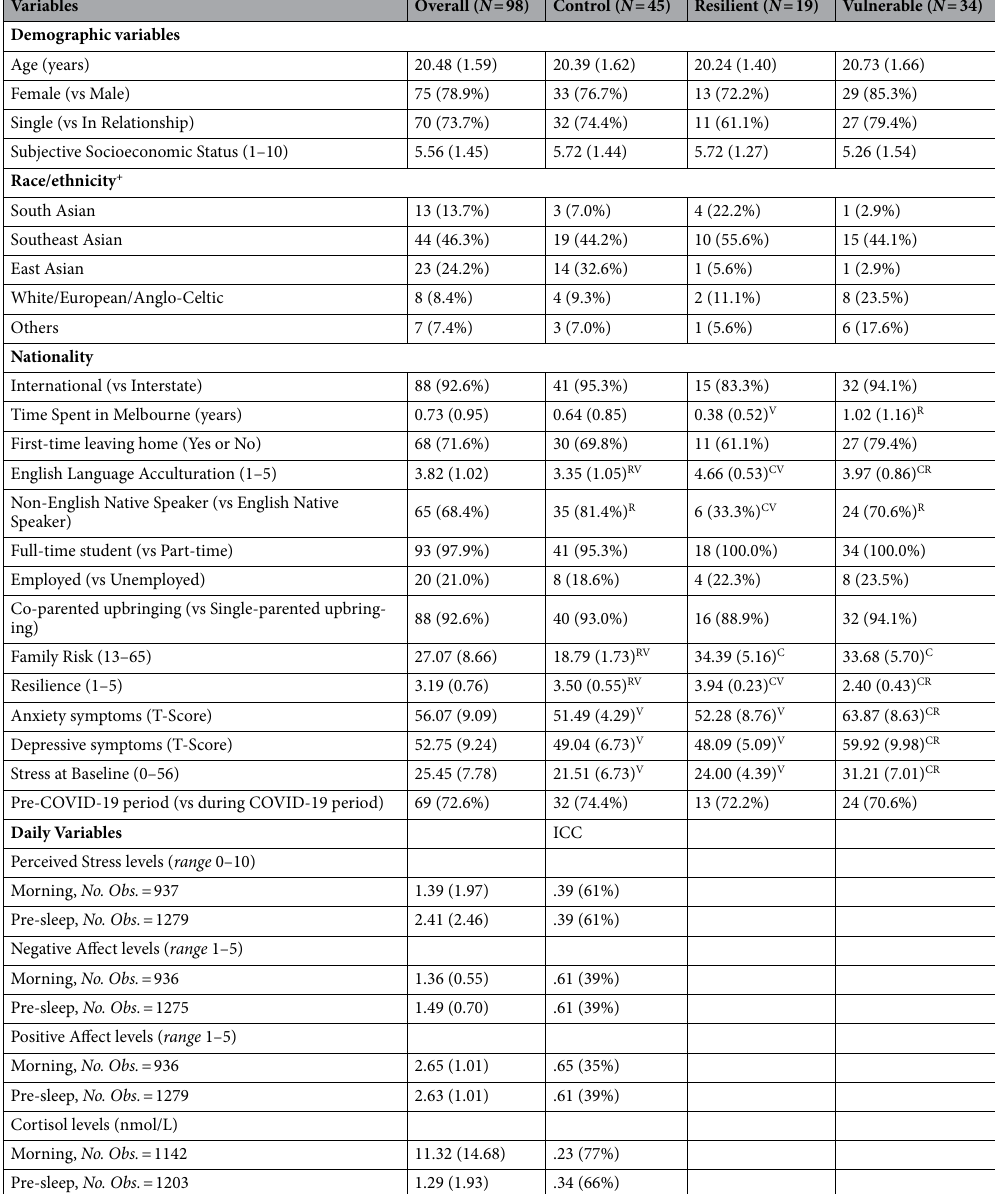
Table 1. Descriptive statistics for demographic and daily variables (N = 95) by groups. ICC Intraclass Correlations, No. of Obs Number of observations. Results are M (SD) for continuous variables and N (%) for categorical ones. Next to each variable, the scale (e.g., years) or possible range of a scale are shown in parentheses for continuous variables. For binary, categorical variables, the reference group is indicated in parentheses. Superscript V, R, and C represent significant differences with the marked group. + Chi-square test was used to examine significant differences in race by group and revealed no significant differences ( p =